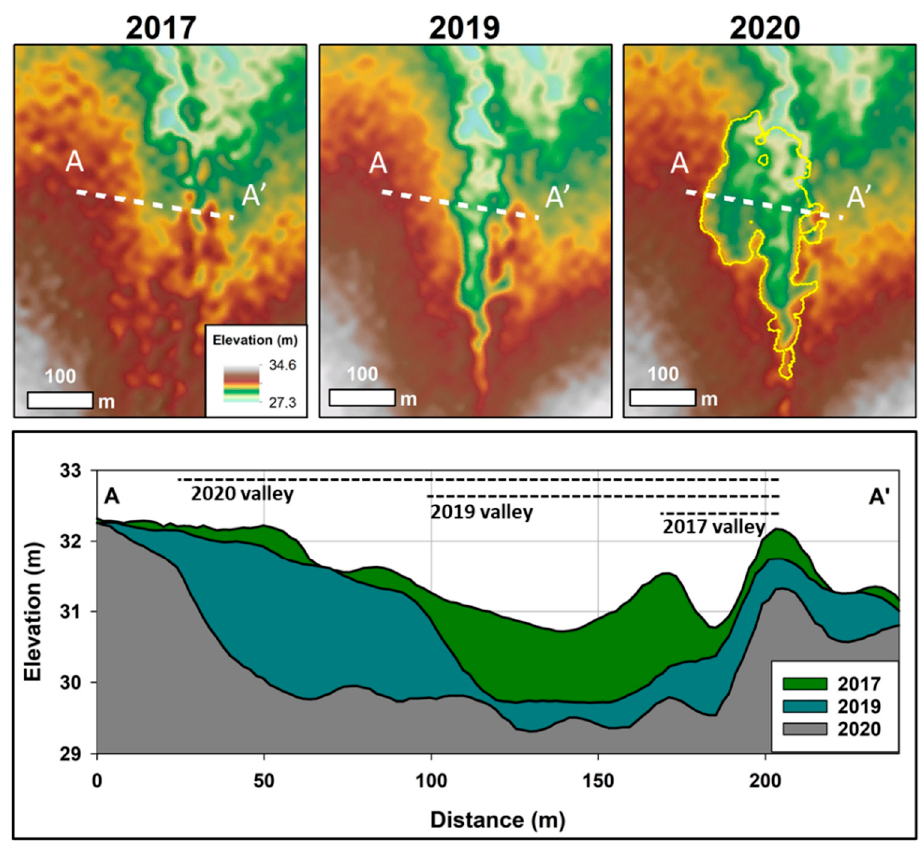
Figure 6. ArcticDEM data from 2017, 2019, and 2020 showing removal of shrub vegetation, beaver- induced fluvio-thermal erosion, and thermokarst at the Swan Lake Creek study site. Analysis of repeat observations in ArcticDEM data show that the Swan Lake Creek valley widened from 33 m in 2017, to 110 m in 2019, to 180 m wide in 2020 primarily as a result of thaw subsidence and lateral erosion into ice-rich permafrost terrain caused by beaver engineering activity. The yellow polygon in 2020 depicts the 35,000 m 2 disturbed area. There was 59,000 m 3 of material lost between 2017 and 2020 due to beaver engineering and permafrost